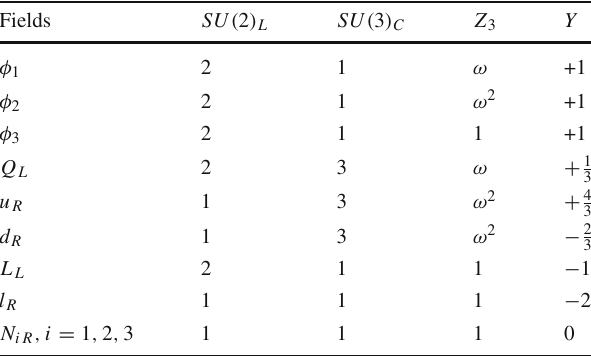
Table 1 Different quantum numbers assigned to the particles in the π model. Here ω = e 2 i